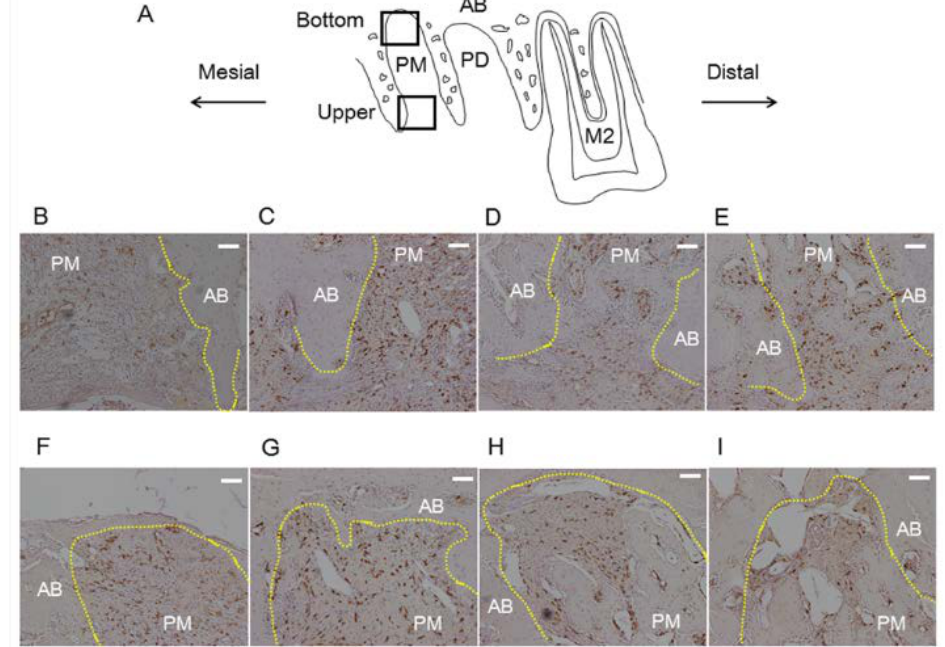
Figure 5. Schematic view and photographs of alveolar socket stained with FGF-2 (Scale bar = 100 μm). Schematic view of upper region and bottom region is shown in ( A ). Photographs of upper region are shown ( B : 3-days control group; C : 3-days experimental group; D : 8-days control group; E : 8-days experimental group). Photographs of bottom region are shown ( F : 3-days control group; G : 3-days experimental group; H : 8-days control group; I : 8-days experimental group). FGF-2-positive cells were stained brown. Expression of FGF-2 in the upper region, but not in the bottom region, was higher in the experimental group than in the control group at 3 days. On the other hand, there were no significant differences in FGF-2 expression in both regions between the groups at 8 days.